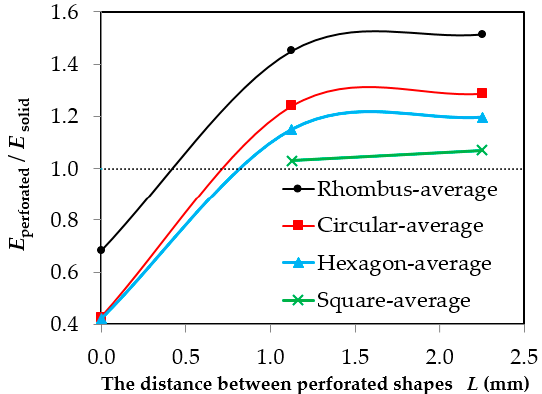
Figure 14. Relation between the ratio of perforated steel sheets modulus of elasticity to control solid steel sheets and the influence of the distance between perforated shapes.